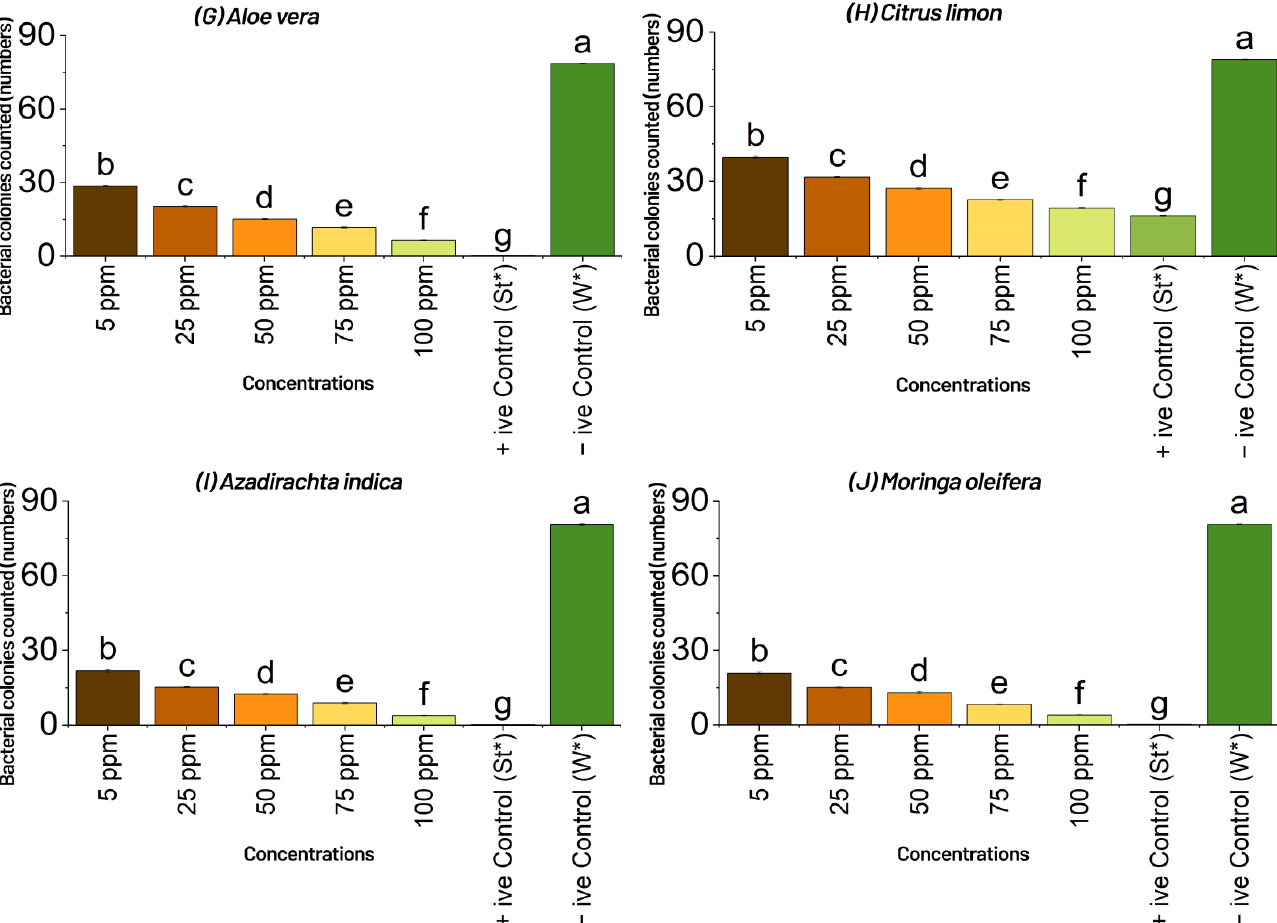
Figure 1. Effect of different concentrations (ppm or µ g mL − 1 = microgram per milliliter) of aqueous plant extracts, viz., ( A ) Syzygium aromaticum , ( B ) Curcuma longa , ( C ) Moringa oleifera , ( D ) Azadirachta indica , ( E ) Mangifera indica , ( F ) Mentha piperita , ( G ) Aloe vera , ( H ) Syzygium cumini , ( I ) Prosopis juliflora and ( J ) Citrus limon , on the number of bacterial colonies of Xcm counted on nutrient agar media by poison food technique in vitro. +ive Control (St*) = Streptomycin, which was used as standard, and similarly, –ive Control (W*) = water, which was used to compare the results with aqueous extracts (botanicals) and streptomycin. Means followed by the same letters in each column are not statistically different when compared with least significant difference ( p < 0.05); ppm = parts per million, which can be expressed as milligrams per liter (mg/L), or the measurement of mass of a chemical, or contaminate per unit volume of water; ppm, or µ g mL − 1 = microgram per milliliter, or mg/L, have the same meaning.